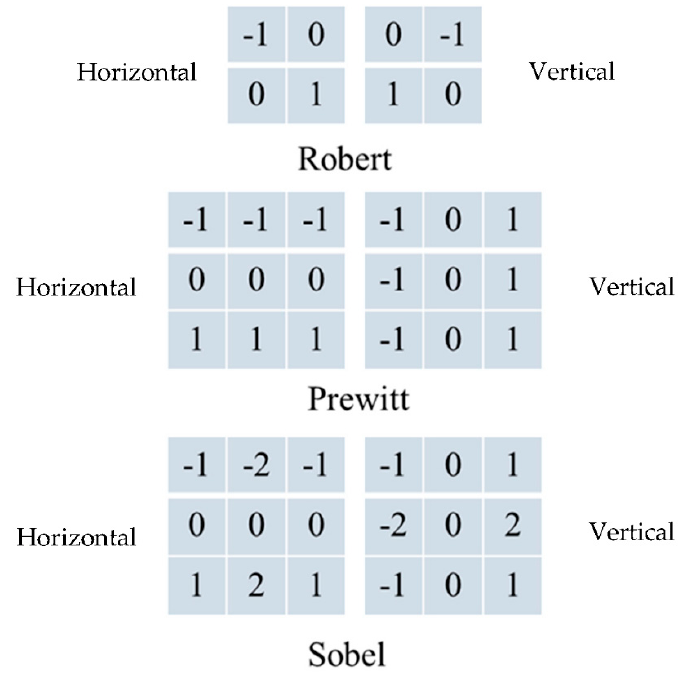
Figure 10. Masks of Roberts cross operator (2 × 2), Prewitt operator (3 × 3), and Sobel operator (3 × 3) for horizontal edge detection and vertical edge detection, respectively.